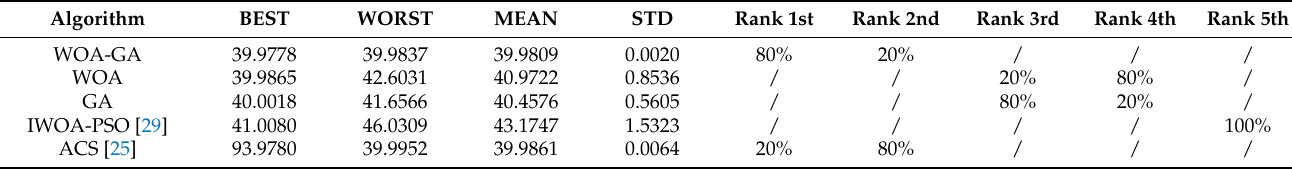
Table 9. Comparisons of the optimization results for the test trajectory planning